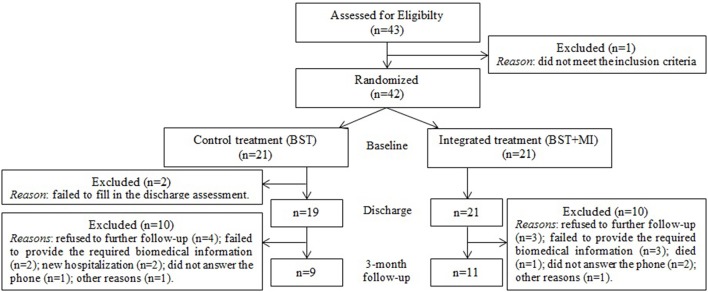
Study flowchart.